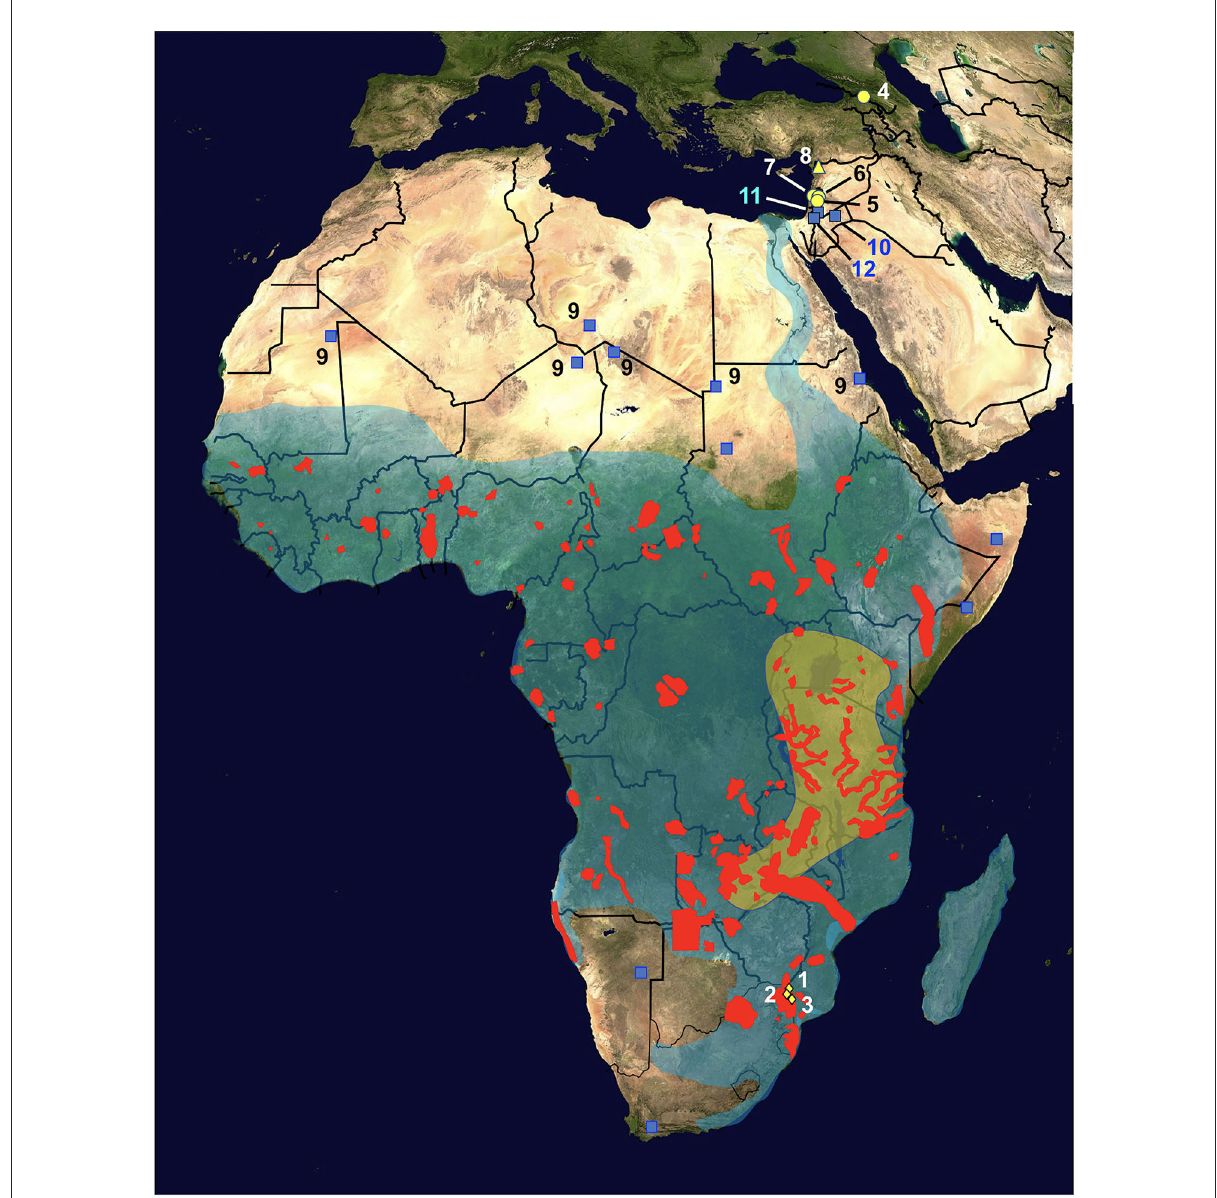
FIGURE2 Map of Africa and Asian Near East showing the distribution of hippopotamus definitive host and radicine snail vector of Fasciola nyanzae . Diamonds = natural reserves where the infected hippopotamuses were found, located in the Mpumalanga province, northeastern South Africa, including Private Nature Reserve 1, Hoedspruit (No. 1), Private Nature Reserve 3 (New camp dam) (2), and Private Nature Reserve 2 (3); red areas = present fragmented distribution of Hippopotamus amphibius ; transparent green area = oldest region of the African hippopotamus according to molecular assessments; yellow circles = fossil remains of Hexaprotodon georgicus in the Caucasus mountains (4) and Hexaprotodon gorgops in the Levantine corridor in archeological sites of northern Israel in Ubeidiyah in the Jordan Rift Valley (5), Gesher Benot Yaakov (6), and Evron (7); yellow triangle = fossil remains of H. amphibius found in Latamne, Syria (8); transparent blue area = present distribution of its snail vector Radix natalensis ; blue squares = isolated populations of R. natalensis outside the general area, including fossil ones in the Sahara desert (9); note populations in Jordan found in Azraq oasis (10) and the Jordan Valley (11), and in Kishda, Palestina (12). Information from various sources (see text). Geographic background from composed satellite map of Africa orthographic projection by NASA (public domain) via Wikimedia Commons. Schema S.